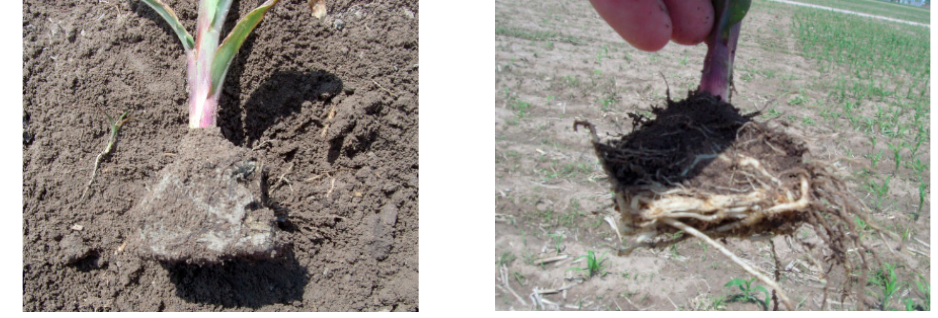
Figure 10. Transplanting effect of seedling tray.